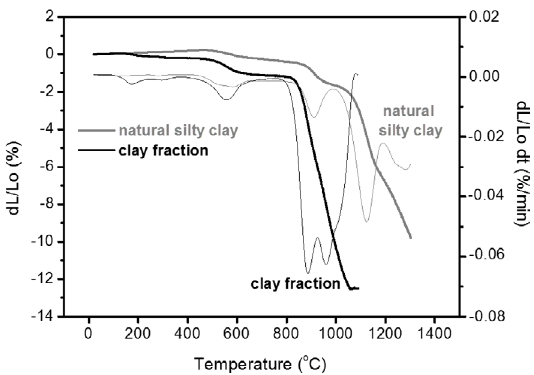
Figure 6. Dilatometric behavior of the natural silty clay and its clay fraction.